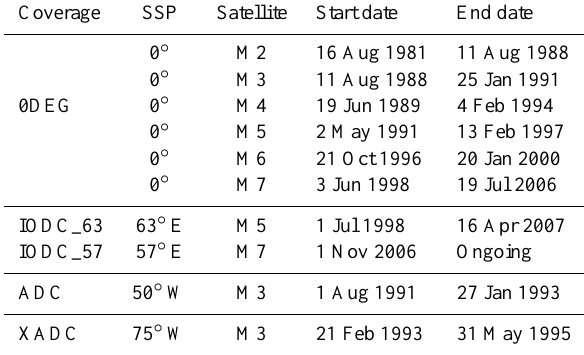
Table 2. Overview of MVIRI observations history in standard operation mode. The coverage acronyms refer to Indian Ocean Data Coverage (IODC) and (Extended) Atlantic Data Coverage ((X)ADC). The corresponding subsatellite points (SSP) are also in-